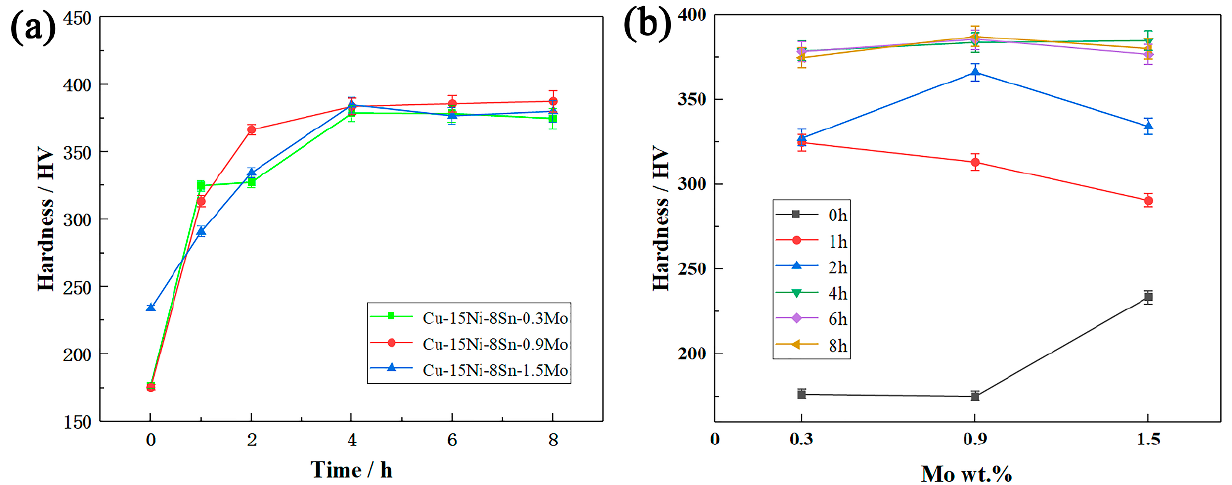
Figure 12. Aging hardening curve of Cu–15Ni–8Sn–xMo (x = 0.3, 0.9, 1.5 wt.%) alloy at 400 °C isothermal aging: ( a ) time–hardness diagram, ( b ) Mo content–hardness diagram.